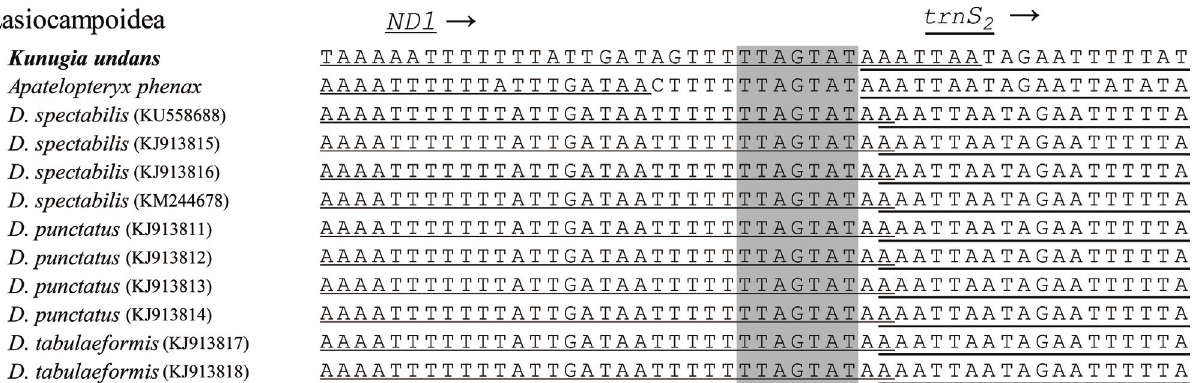
Figure 4 - Alignment of the internal spacer sequence located between ND1 and trnS 2 of Lasiocampoidea, including Kunugia undans . The shaded nucleo- tides indicate the conserved heptanucleotide (TTAGTAT) region. Underlined nucleotides indicate the adjacent partial sequences of ND1 and trnS 2 . Ar- rows indicate the transcriptional